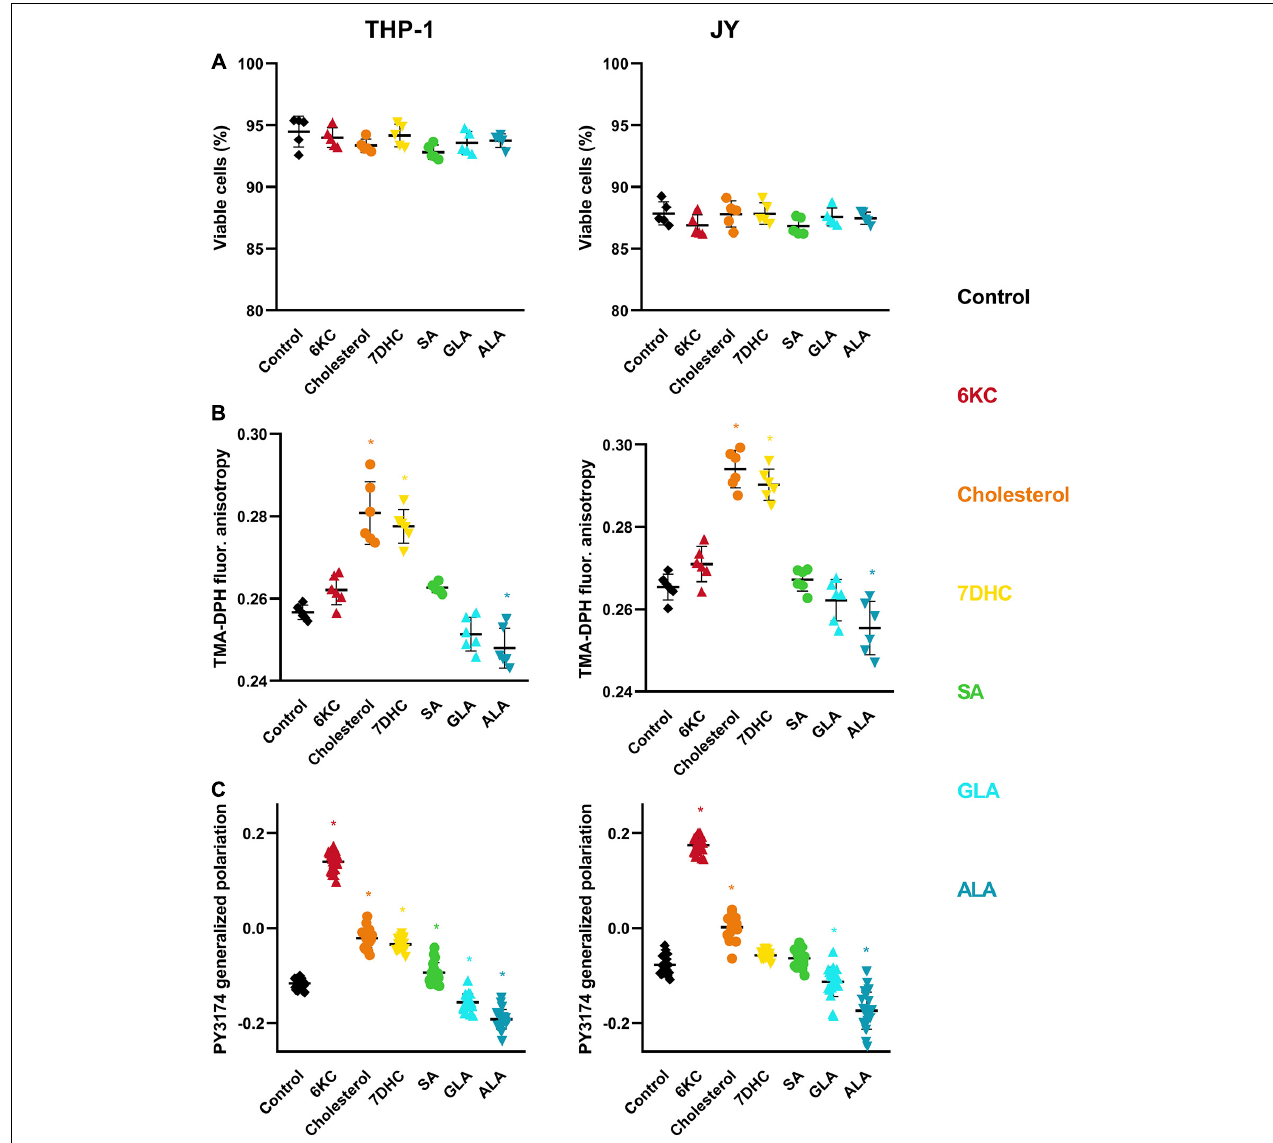
FIGURE 4 | Effects of sterols and fatty acids on cell viability, membrane fluidity and hydration. (A) THP-1 or JY cells were treated with 200 µ M 7DHC (yellow), cholesterol (orange) or 6KC (red) for 1 h, or 50 µ M ALA (blue), GLA (cyan) or SA (green) for 48 h, and subsequently labeled with the necrosis marker Sytox Green and the apoptosis marker AlexaFluor647-conjugated annexin V. Fluorescence intensities of individual cells were measured using a flow cytometer and the fraction of Sytox Green and annexin V negative living cells was calculated for each sample containing at least 20,000 cells. Fractions of living cells obtained in five independent experiments and their average values ( ± SD) are plotted for the different treatments. (B) THP-1 and JY cells treated as above were labeled with TMA-DPH and the fluorescence anisotropy of the fluorophore was determined with spectrofluorometry. Anisotropy values obtained in six independent experiments and their average values ( ± SD) are plotted for the different treatments. (C) THP-1 and JY cells treated as above were labeled with PY3174 and the generalized polarization of the dye localized in the cell membrane was determined using confocal microscopy and quantitative image analysis. Mean generalized polarization values of 20 individual images obtained in five independent experiments and their average values ( ± SD) are plotted for the different treatments. Each image contained data of 10–15 cells of normal morphology with a total number of 200–300 cells per treatment. Asterisks (*) indicate significant differences compared to control samples ( p < 0.05, ANOVA followed by Tukey’s HSD